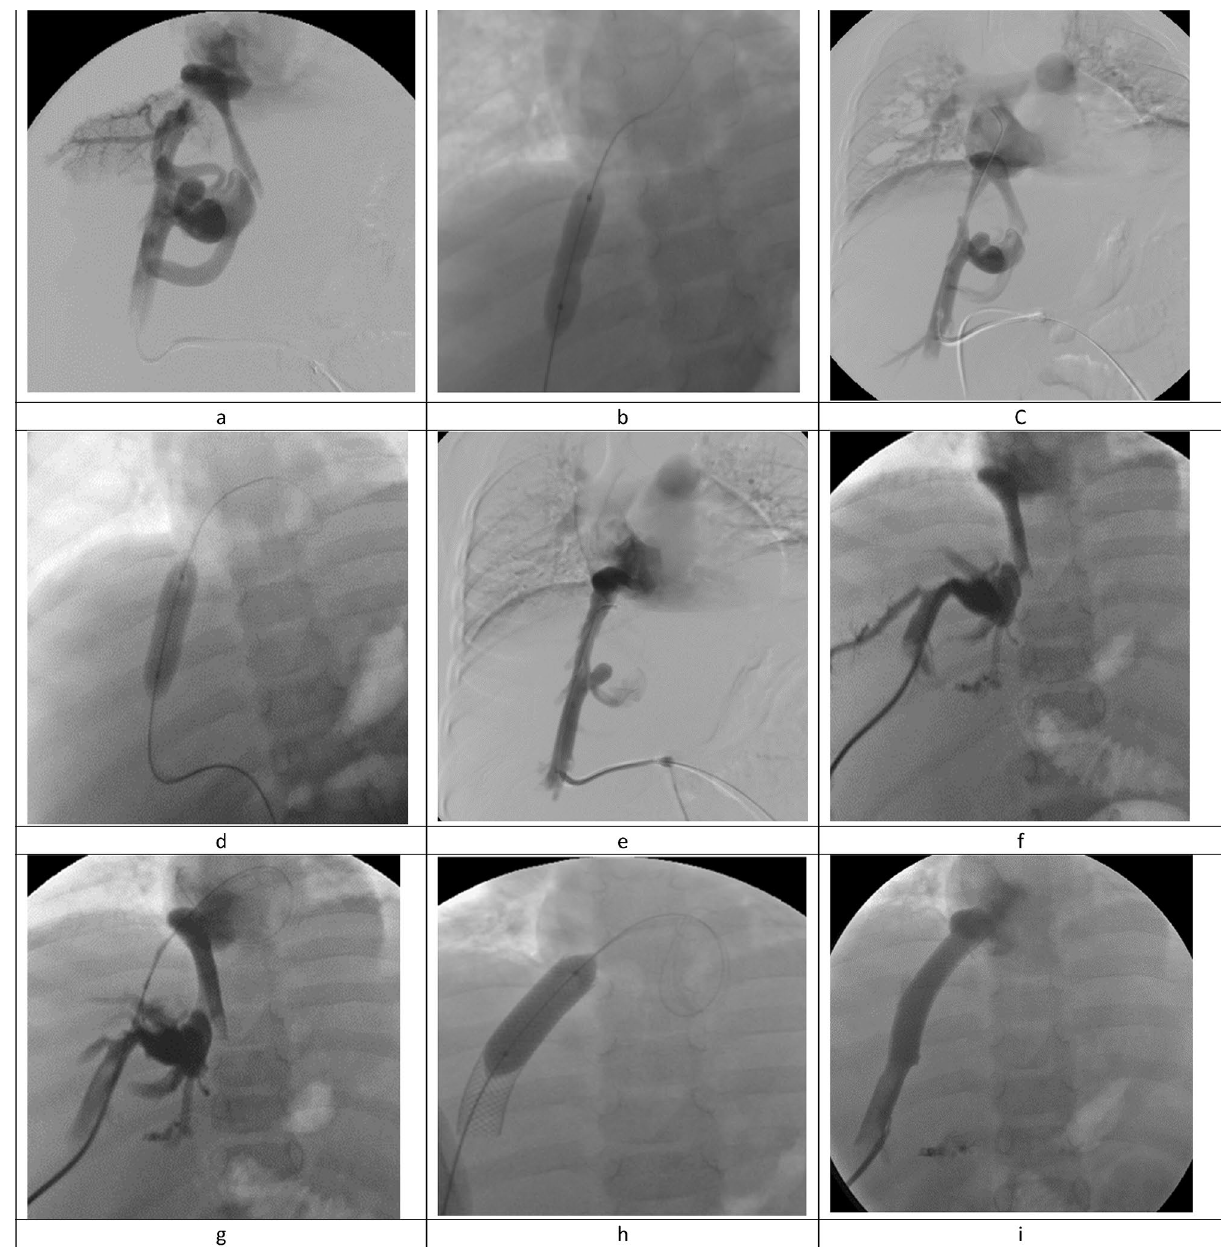
Figure 1. Angiography images of a 15-year-old female patients with FVLM: factor V Leiden mutation (FVLM) with obstruction of the right hepatic vein for 6 months. Transhepatic venography revealed short segment obstruction involving right HV ostium with multiple dilated vascular collaterals ( a ). Balloon dilatation was performed ( b ), venography revealed residual stenosis and persistence of collaterals ( c ). Repeat dilatation was performed ( d ) and control venography revealed good recanalization of the HV with disappearance of vascular collaterals and without residual stenosis ( e ). Patient presented with recurrent symptoms 10 months following HV angioplasty, and color Doppler ultrasonography revealed thrombosis of the previously treated right HV. Angiography revealed progressive thrombosis of the treated HV compared to the primary intervention with vascular collaterals ( f ). The obstruction was bypassed using a transhepatic approach ( g ) followed by stent insertion ( h ). Final venography following stent dilatation revealed free flow of contrast agent across the stent with disappearance of intrahepatic collaterals ( j